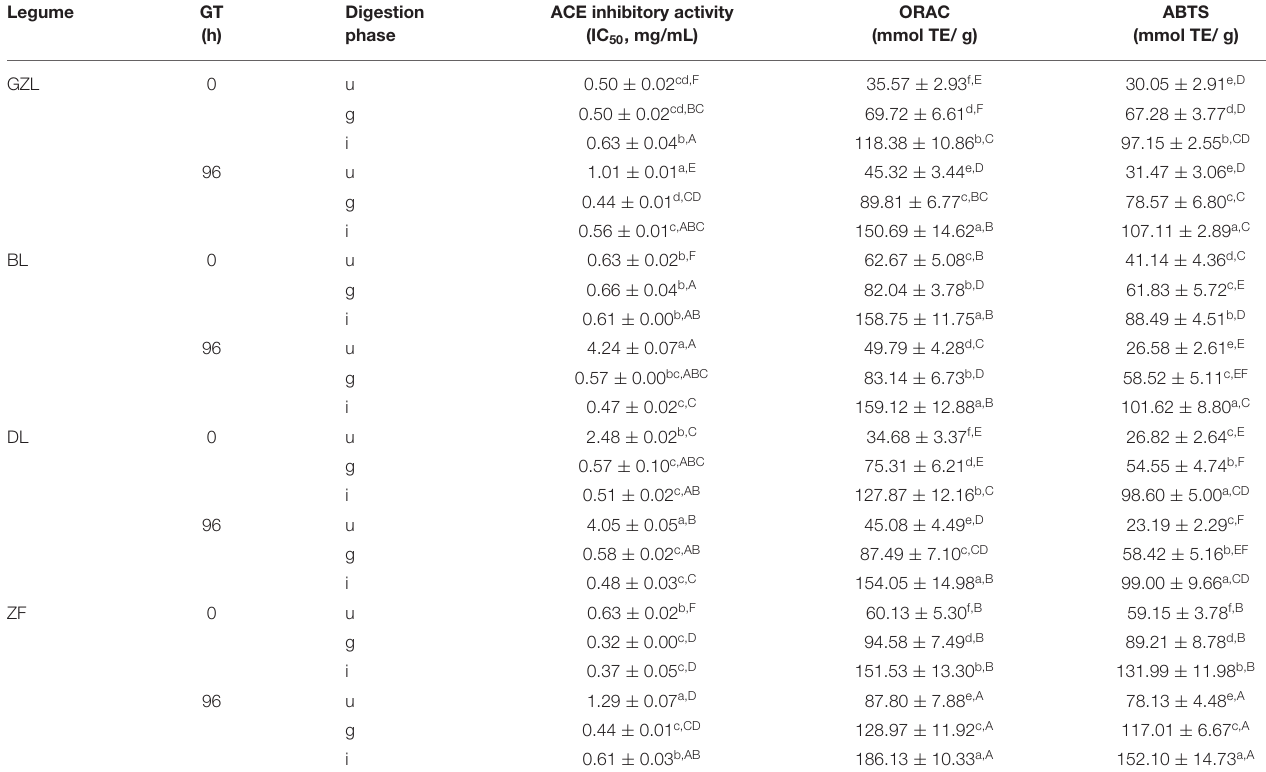
TABLE 3 | ACE inhibitory activity, ORAC, and ABTS scavenging activity of raw and sprouted legumes at different phases of gastrointestinal digestion.